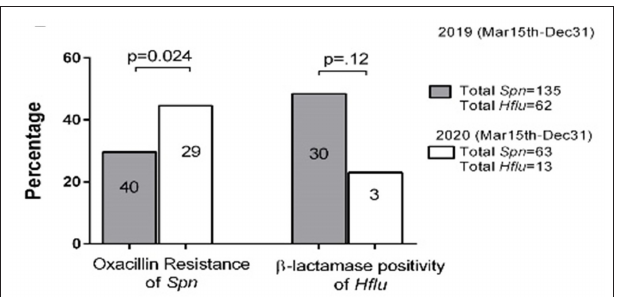
FIGURE 2 | Oxacillin susceptibility and β -lactamase activity comparison in S. pneumoniae ( Spn ) and H. influenzae ( Hflu ) strains, respectively, before and during the pandemic isolated from NP of children during colonization and AOM cases. All M. catarrhalis ( Mcat ) strains were β -lactamase positive (not shown). The number in the bar = oxacillin-resistant and β -lactamase isolates in different times. The Y -axis represents the percentage of oxacillin-resistant and β -lactamase positivity among all